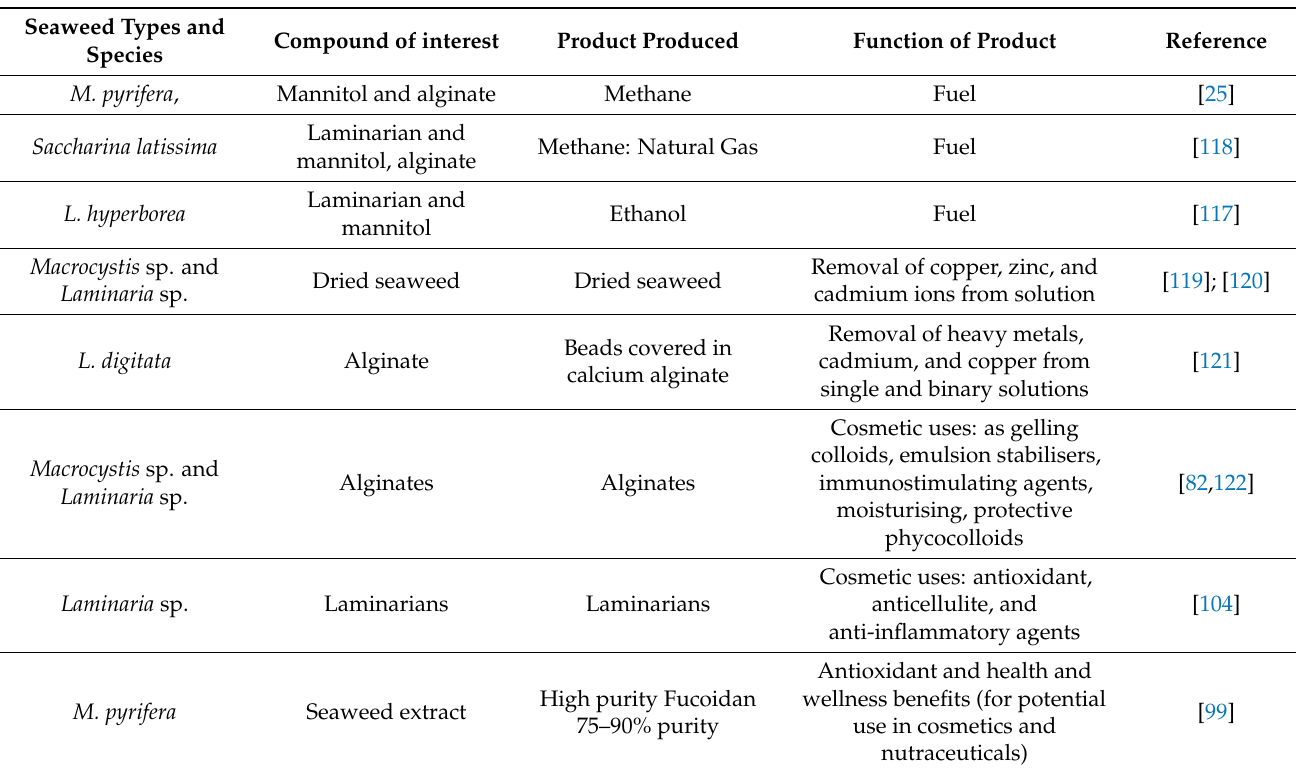
Table 3. Other current uses of brown seaweeds Macrocystis sp. and Laminaria